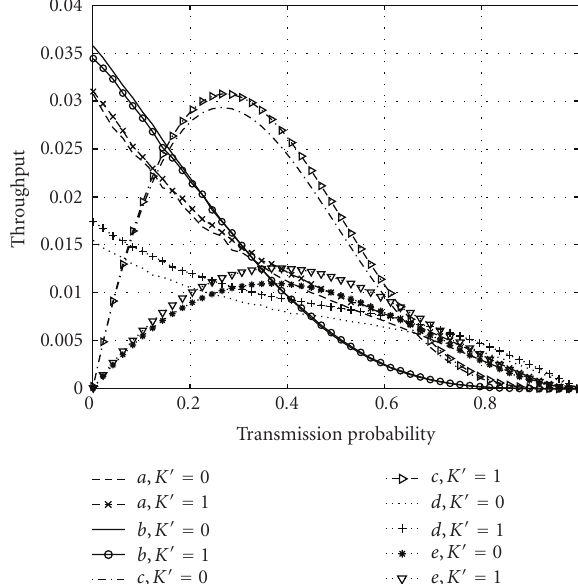
Figure 14: Throughput of the dynamic ( K (cid:5) = 1) and static ( K (cid:5) = 0) cases for K = 4 (asymmetric network of Figure 11).